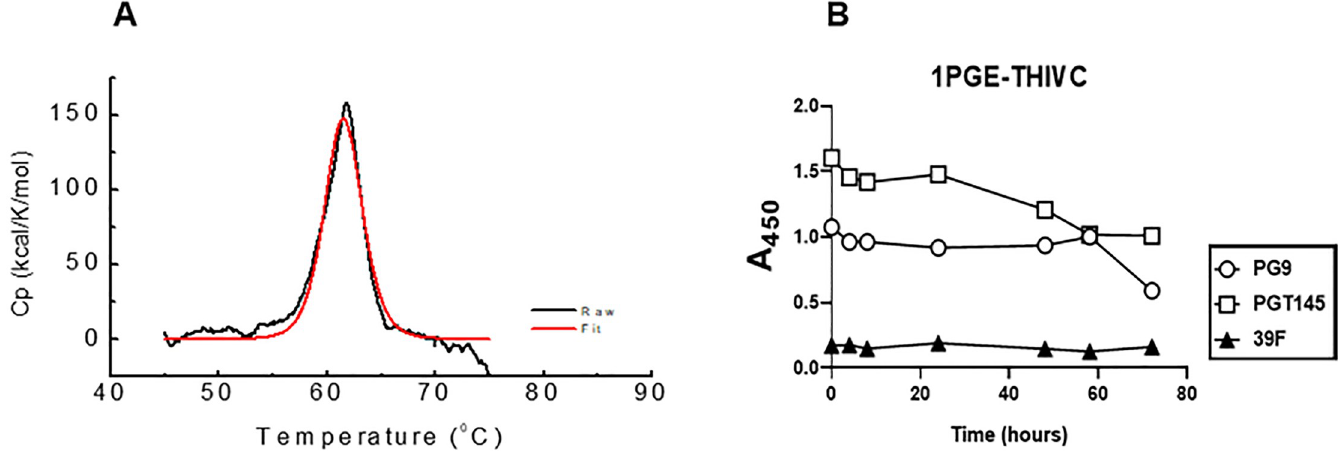
Fig 4. Examining the stability of 1 PGE-THIVC SOSIP trimer. A . Differential scanning calorimetry (DSC) of the SOSIP trimer; Cp , specific heat capacity. B. Time course of binding of 1PGE-THIVC to bnAbs PG9, PGT145 and a non-neutralizing mAb 39F at 37˚C.